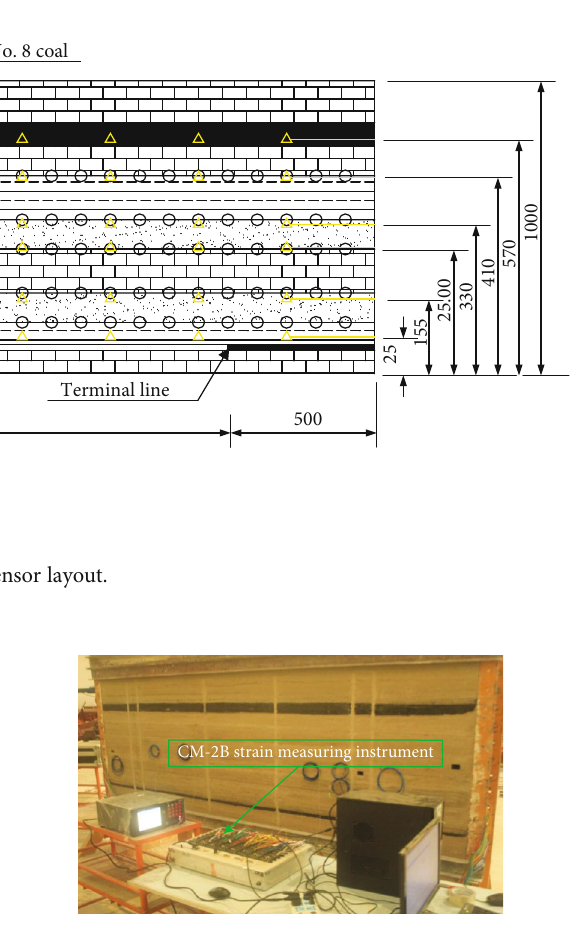
Figure 3: E ff ect diagram of model observation